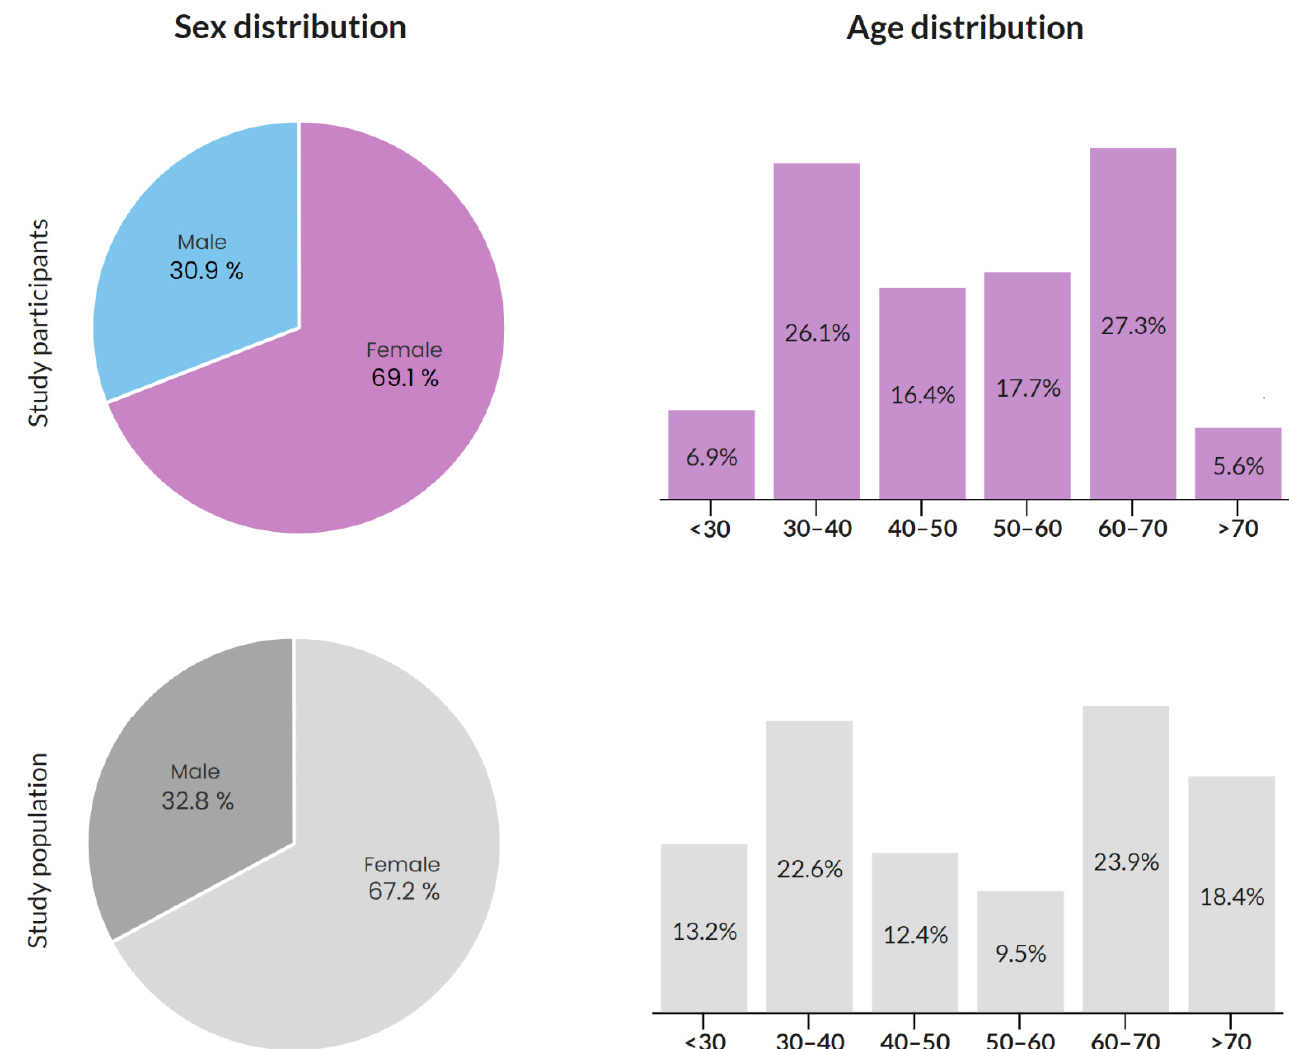
Figure 1. Sex and age distribution of the study participants and the study population.